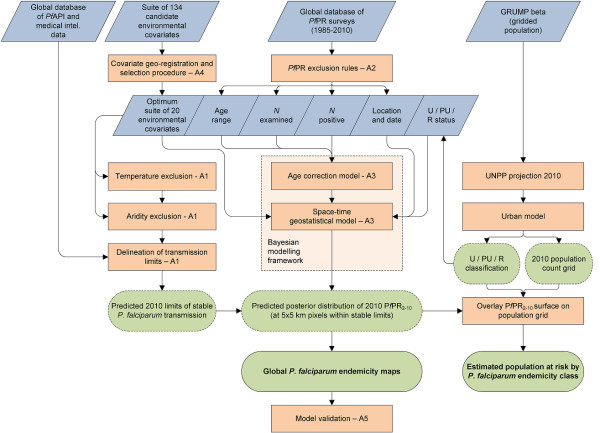
Schematic overview of the mapping procedures and methods for Plasmodium falciparum endemicity. Blue boxes describe input data. Orange boxes denote models and experimental procedures; green boxes indicate output data; dashed lines represent intermediate outputs and solid lines final outputs. U/PU/R = urban/peri-urban/rural; UNPP = United Nations Population Prospects. Labels A1-5 denote supplementrary information in Additional files 1, 2, 3, 4 &5.